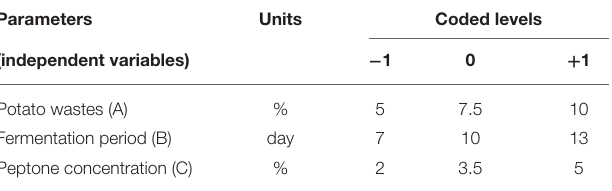
TABLE 1 | Values of independent variables in the Box-Behnken design.